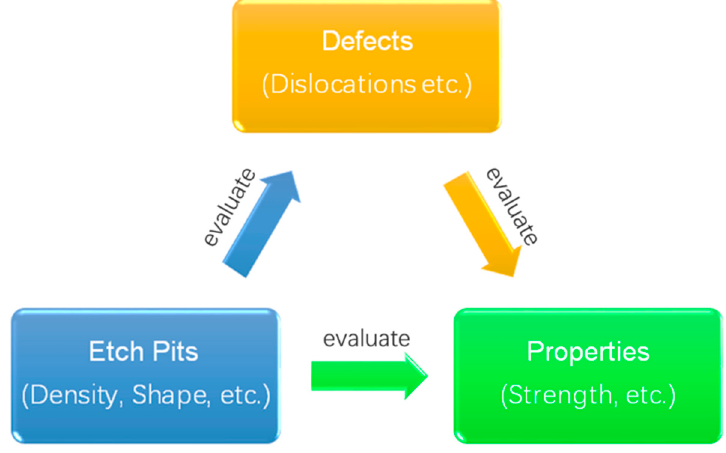
Figure 5. Schematic diagram of the relationship of etch pits, defects, and properties.